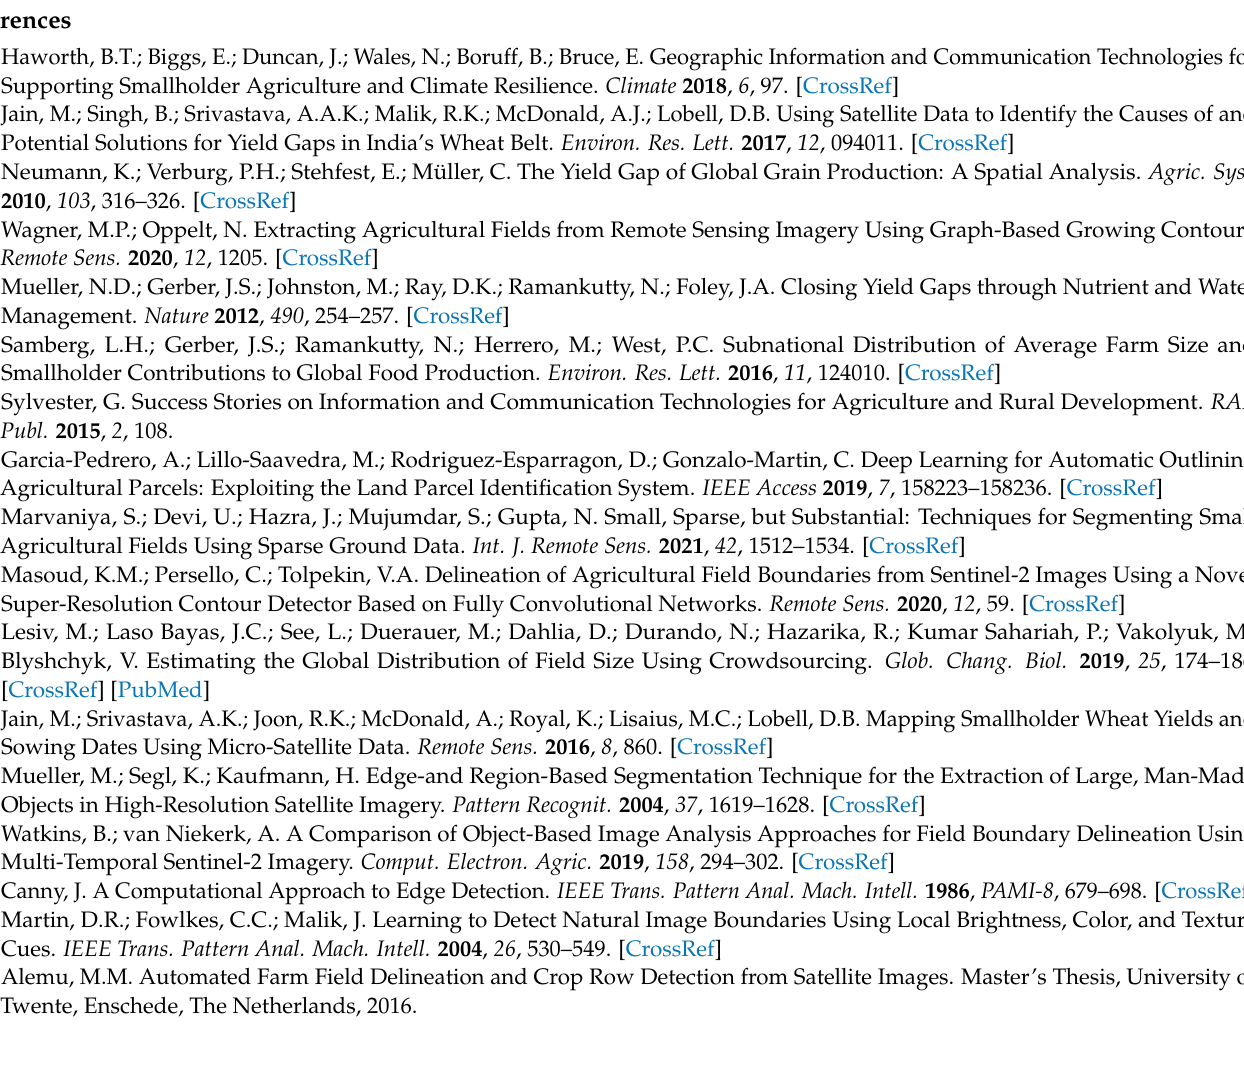
Figure S4: One example of a 512 × 512 pixels WV-3 enhanced tile in Bihar; Figure S5: Examples of common issues (I to VlI, detailed in text) across different model results (columns a through f) from Bihar; Figure S6: One example of a 512 × 512 pixels WV-3 enhanced tile in Uttar Pradesh; Figure S7: Examples of common issues (I to VlI, detailed in text) across different model results (columns a through f) from Uttar